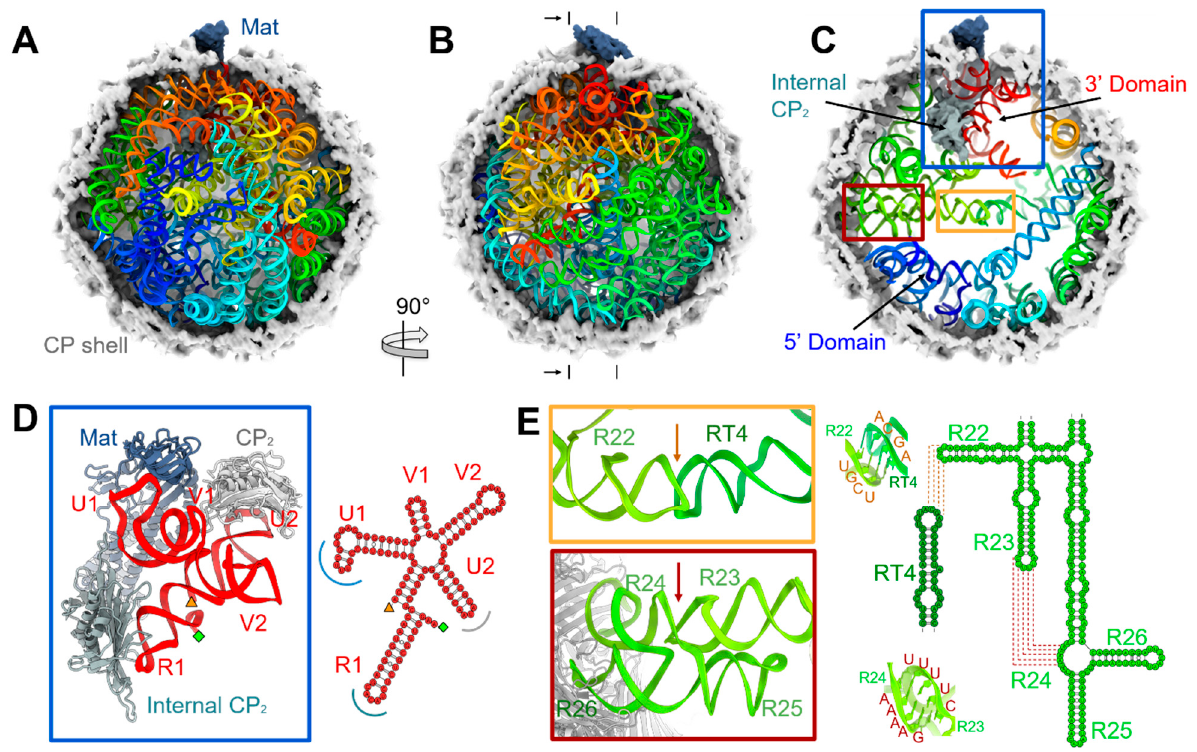
Figure 1. The complete model of the dominant gRNA fold in Q β . ( A ) The cut-open view of the Q β virion to display the gRNA, shown as ribbons and rainbow-colored from the 5 ′ end (blue) to the 3 ′ end (red). The CP shell and Mat are shown as electron density, colored light grey, and dark blue, respectively. ( B ) The view from Panel A vertically rotated 90° with half of the CP shell removed. ( C ) Cross-section from between the marks in Panel B and viewed from the black arrows. The internal CP dimer (Internal CP2), and the 5 ′ and 3 ′ gRNA domains are light blue, blue, and red, respectively. ( D ) Left: zoomed-in view within the blue box in Panel C showing the gRNA 5-way junction domain (red) interacting with the Mat (dark blue), an exposed CP dimer (CP2, grey), and the internal CP